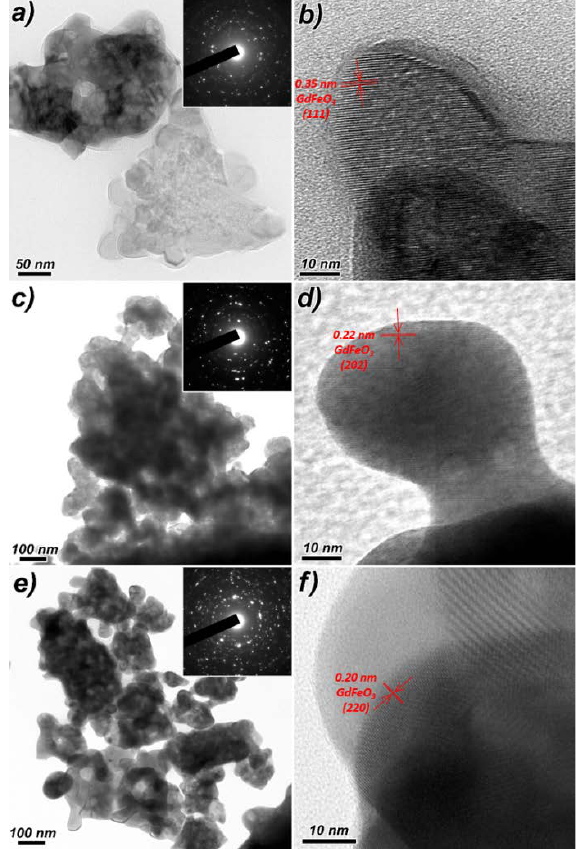
Figure 6. HRTEM images of the GdFeO 3 nanoparticles obtained using direct (GFO-D: a , b ), reverse (GFO-R: c , d ) and microreactor (GFO-M: e , f ) co-precipitation techniques. The SAED patterns of the corresponding samples are shown as insets in the survey HRTEM images ( a , c , e ).